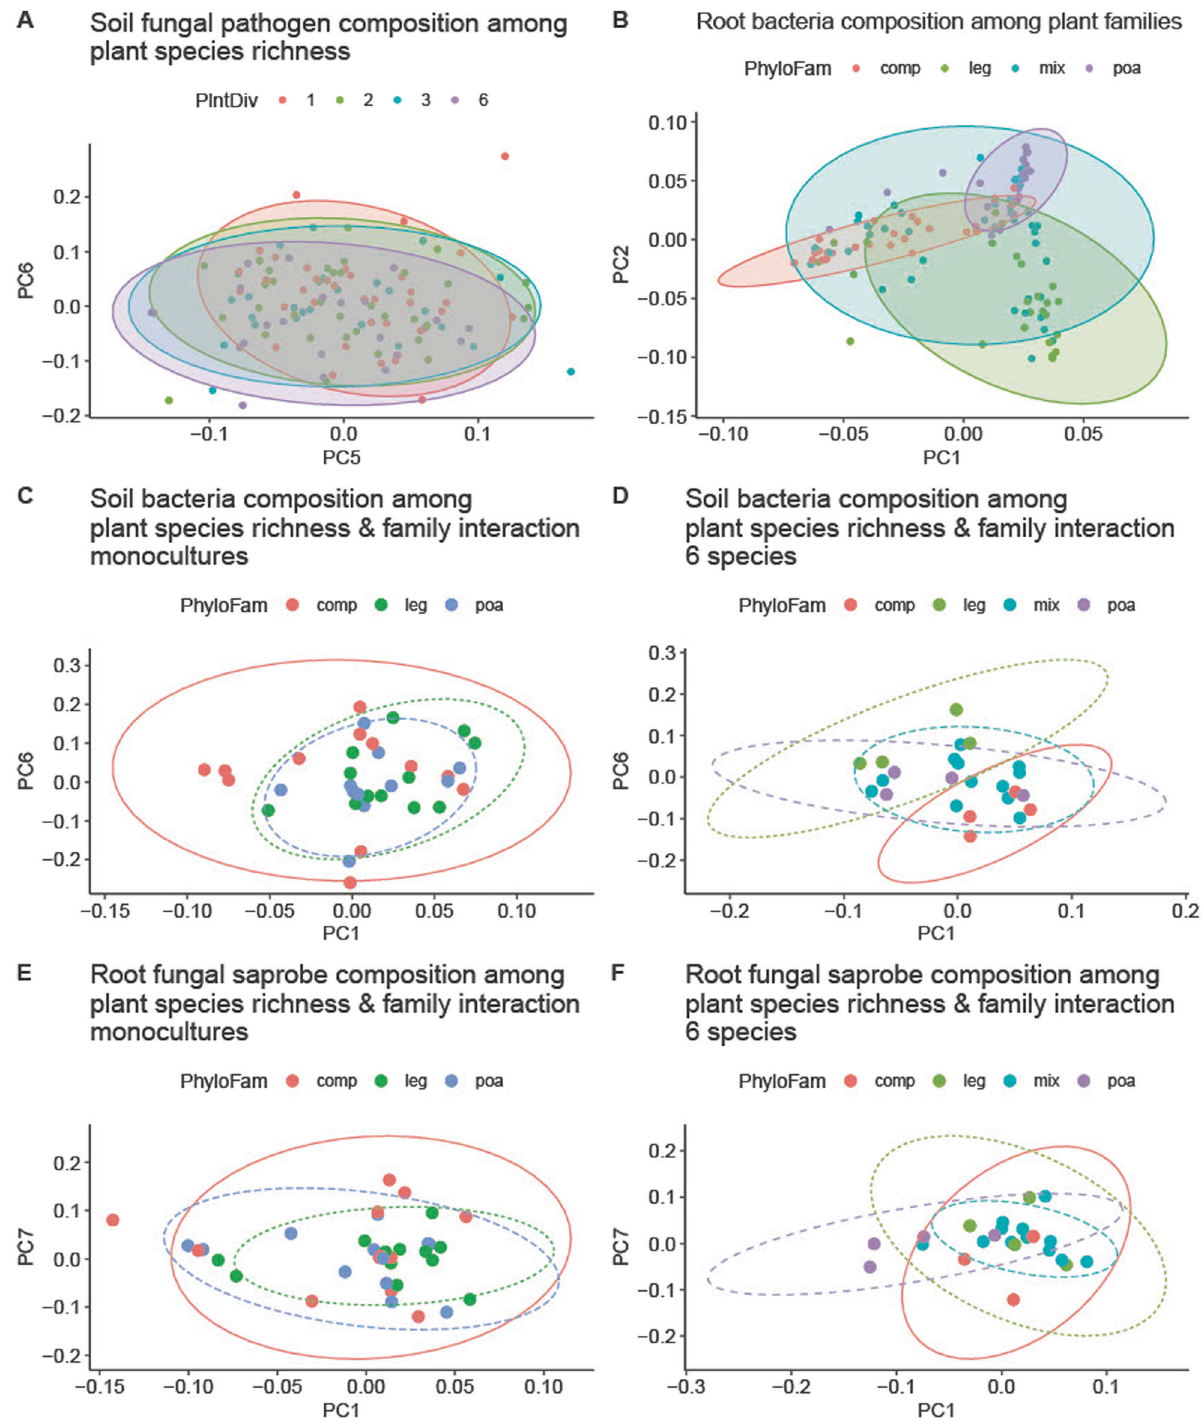
Fig. 4 Microbial composition response to plant species richness and plant family composition treatments. PCA plots showing ( a ) soil fungal composition response to plant species richness ( p = 0.03, Table 2), ( b ) root bacteria composition response to plant family ( p = 0.001, Table 2), soil bacteria composition response to the interaction of plant species richness and plant family ( p = 0.02, Table 2), monocultures depicted in c and 6-species treatment shown in d . 2-species and 3-species interaction plots found in Supplementary Appendix Fig. 3. Root fungal saprobe composition differentiation in response to the interaction of planted species richness and plant family ( p = 0.03, Table 2) shown in monoculture ( e ) and 6-species ( f ), with 2- and 3-species plots found in Supplementary Appendix Fig. 3. P -values reported are from PERMANOVA of microbial bray-curtis dissimilarity response to the model, as shown in detail in Table